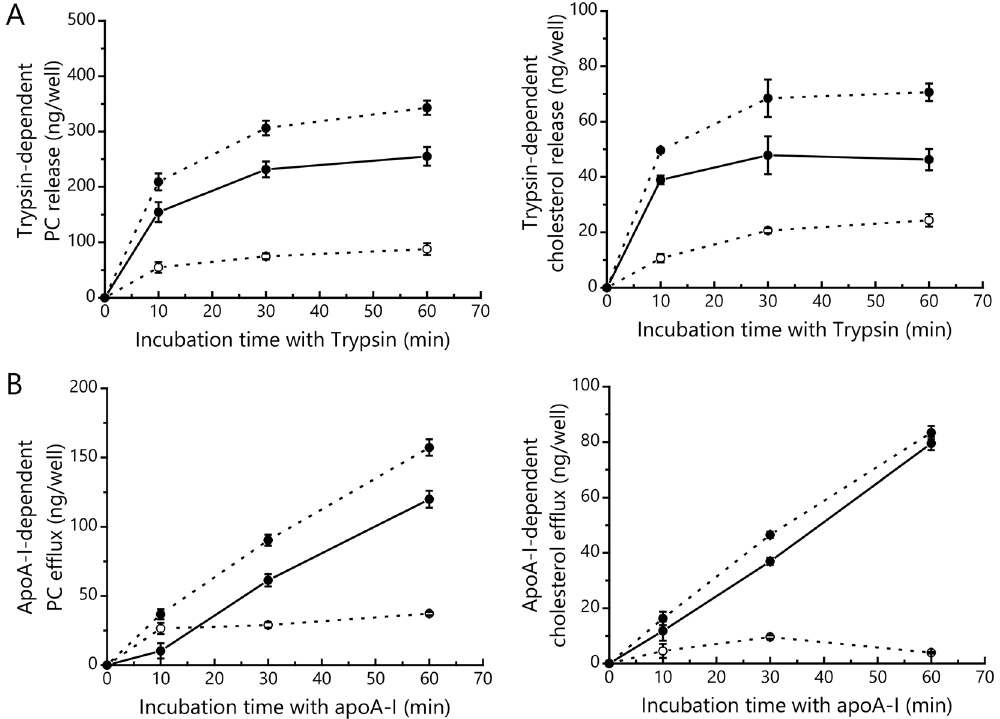
Figure 2. Incubation-time dependence of trypsin-dependent PC and cholesterol release ( A ) and apoA-I– dependent PC and cholesterol efflux ( B ). BHK/Mock ( ○ , dotted line) and BHK/ABCA1 ( ● , dotted line) cells were incubated with either 50 μ g/mL trypsin (A) or 10 μ g/mL apoA-I ( B ) for 0, 10, 30, or 60 min at 37 °C. After the incubation, amounts of PC and cholesterol in the medium were measured. ABCA1-specific release of PC and cholesterol ( ● , solid line) were calculated by subtracting the measured level of release from BHK/Mock cells from the measured level of release from BHK/ABCA1 cells. Experiments were performed in triplicate, and the average values are shown with